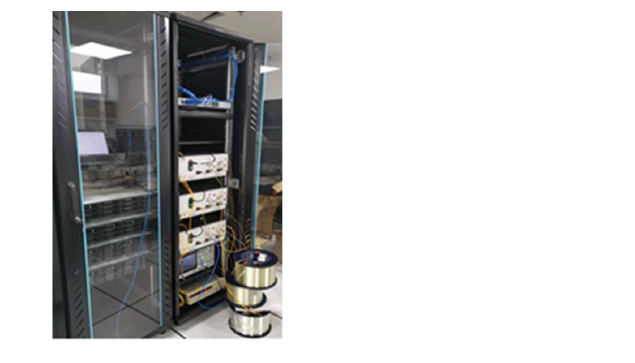
Figure 12. Cascade experiment of ring network using three equipment.